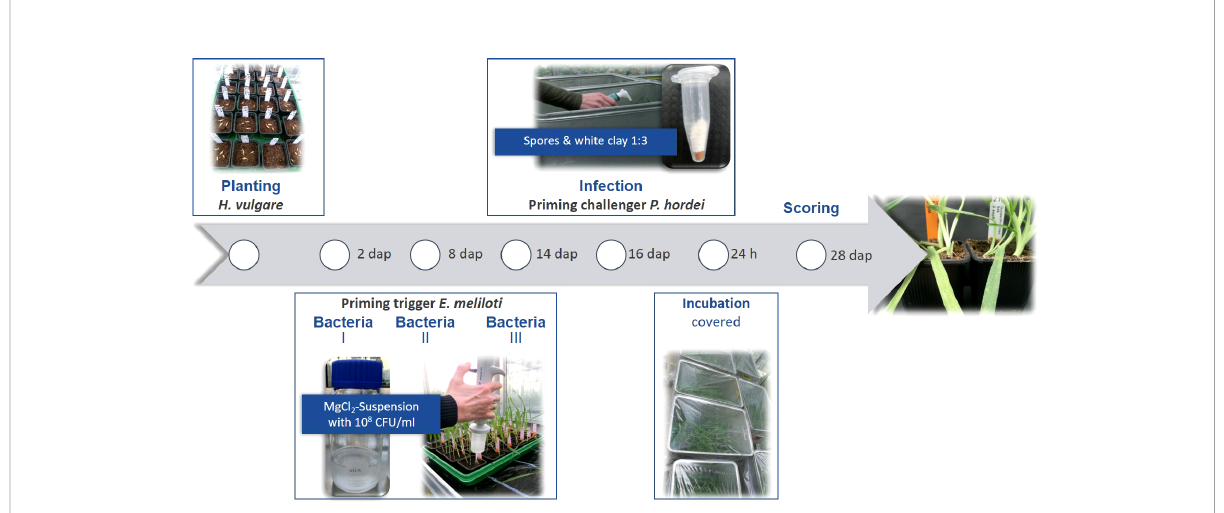
FIGURE 1 Experimental work fl ow of the priming treatment with E. meliloti followed by P. hordei infection and symptoms scoring. Days after planting –